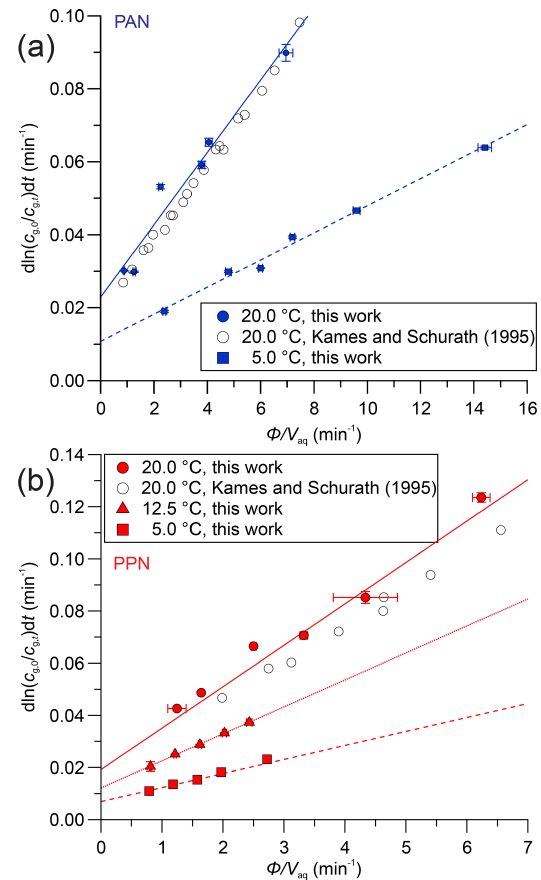
Figure 4. (a) Plots of dln( c g , 0 /c g ,t ) / d t versus (cid:56)/V l for PAN in DI water at 20.0 ◦ C ( • ) and 5.0 ◦ C ( (cid:4) ). Literature data at 20.0 ◦ C were extracted from Figs. 4 and 5 of Kames and Schurath (1995) using “Engauge Digitizer” software (Mitchell et al., 2020) and are shown as open symbols ( ◦ ). The lines are linear fits to the data at each temperature. (b) Same plot as panel (a) but for PPN in DI water and also showing data at 12.5 ◦ C ( (cid:78)